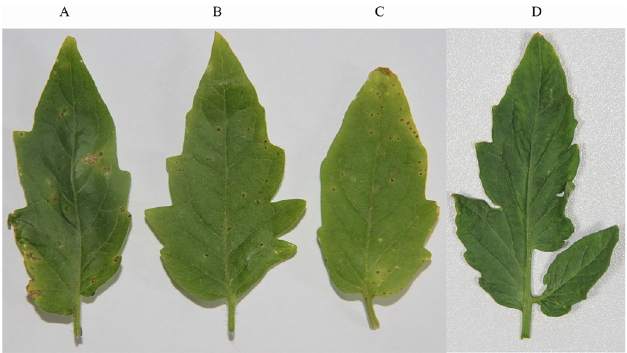
Fig 6. Effect of fur in Xv virulence on tomato leaves. Fifty-day-old tomato plants (cv No.4 Zhongshu) were spray inoculated with A) Xv 17; B) fur-m; C) fur-c; and D) LB medium (negative control).